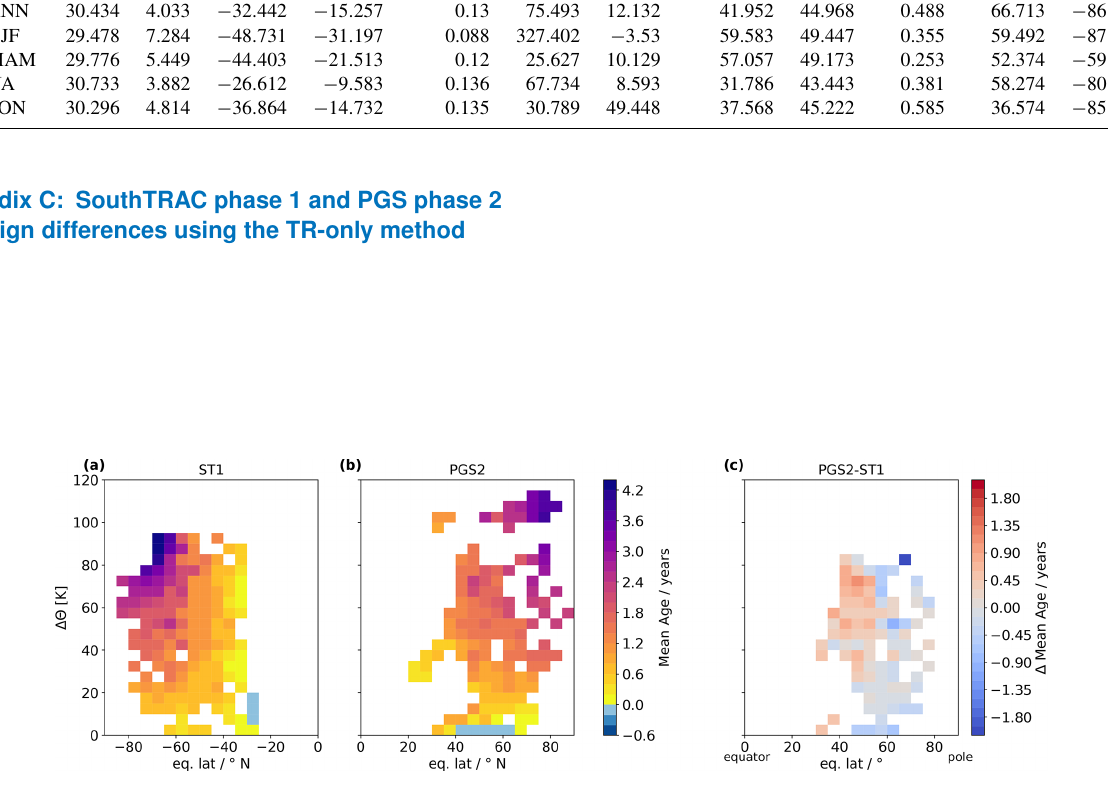
Code and data availability.